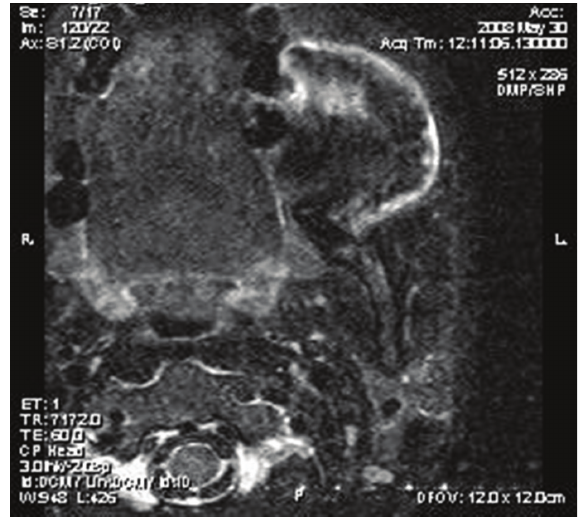
Figure 2: T 1 -weighted axial image showing well-marginated isoin- tense soft tissue lesion with few hypointense areas within.